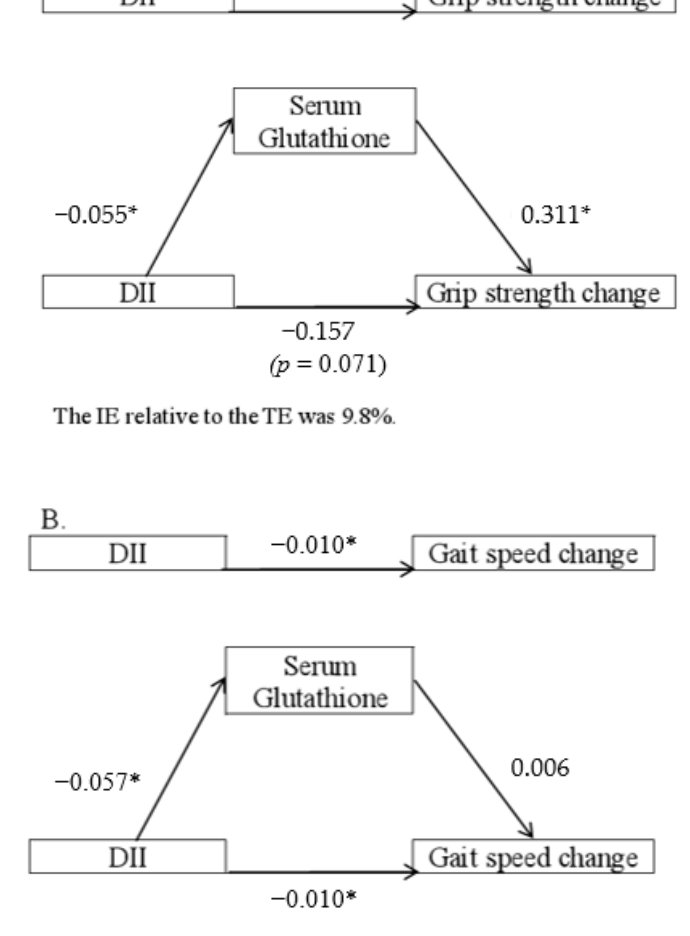
Figure 1. The mediation role of serum glutathione in the relationship between baseline dietary inflammatory index (DII) and the longitudinal changes of ( A ) hand grip strength and ( B ) gait speed (value at year 4 subtracted that at baseline). Notes: the β was adjusted for corresponding baseline measurement, body mass index, estimated glomerular filtration rate, current smoking, physical activity level, previous fracture, hypertension, diabetes, chronic obstructive lung disease, cardiovascular disease, rheumatoid arthritis, nonsteroidal anti-inflammatory agent use, and osteoporosis medication in the fully adjusted models. * p <